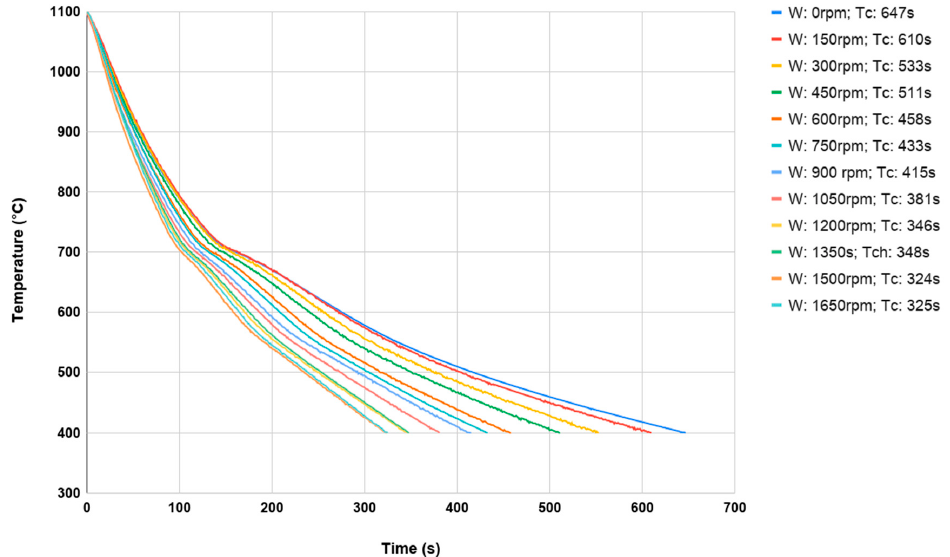
Figure 9. The cooling curves of a samples made of 16MnCr5 ⌀ 35 × 40 mm from forging temperature 1100 °C to 400 °C.